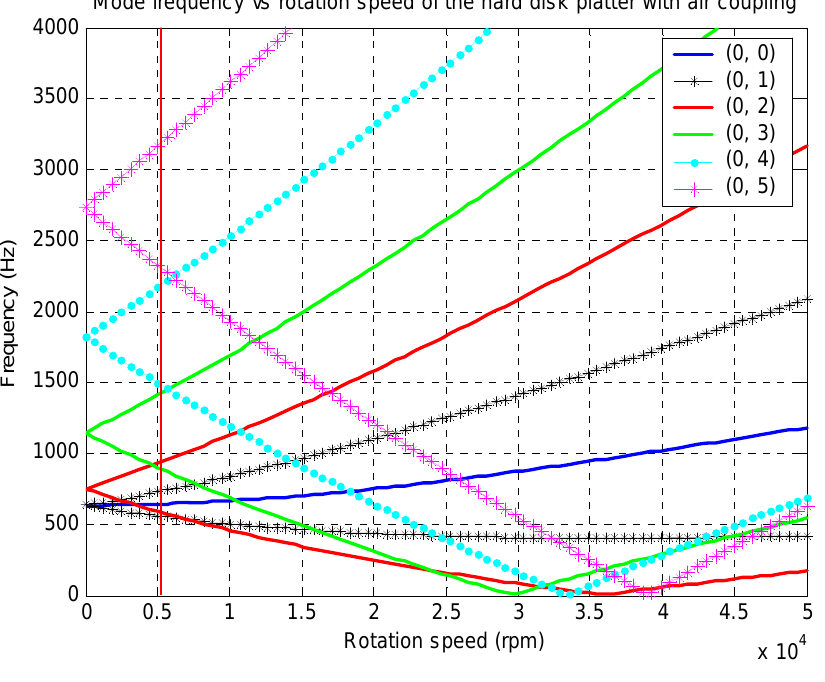
Figure 6. Mode frequency versus rotational speed of disk platter in the enclosure with air coupling.